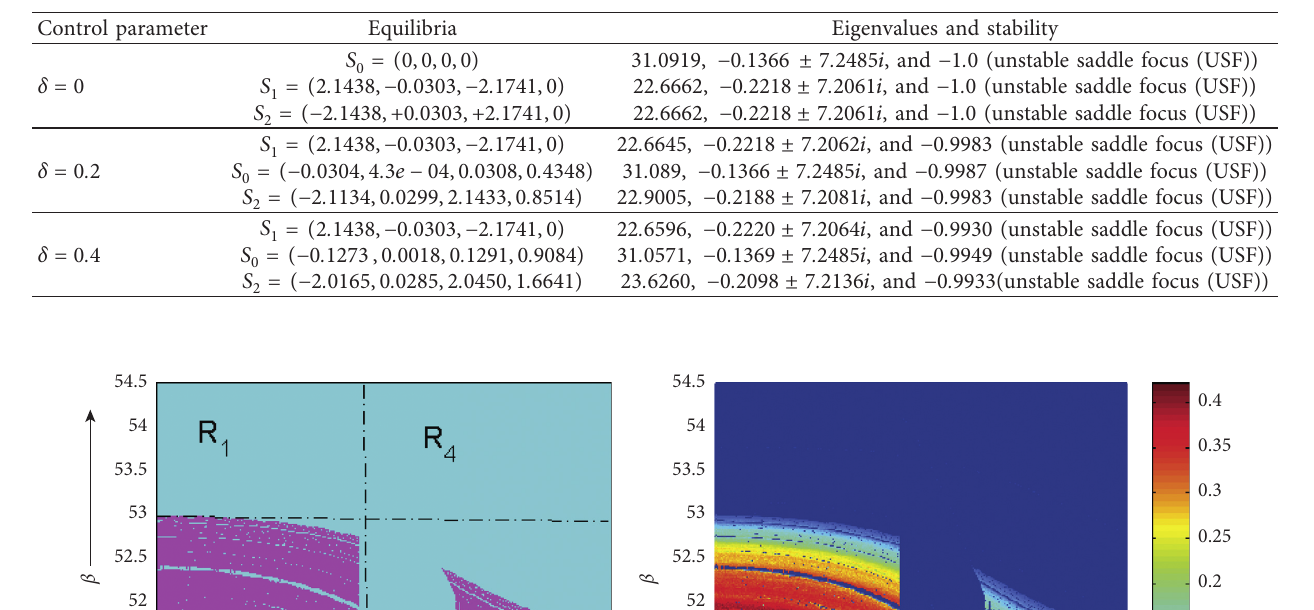
Table 1: Equilibrium points of controlled Chua’s oscillator, the corresponding eigenvalues, and their stability for some discrete values of the control